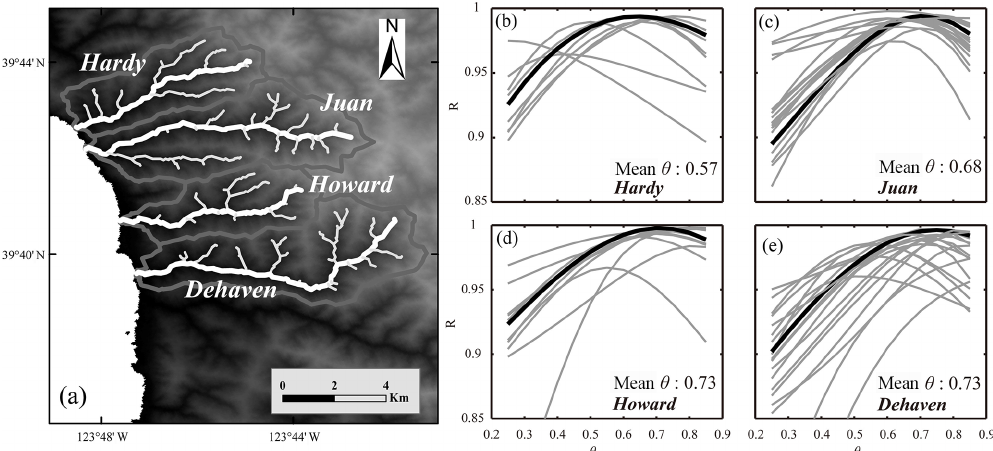
Figure 11. Correlation coefficients of χ − z plots as a function of θ . (a) Location of the streams. (b–e) Correlation coefficients of χ − z plots based on a range of θ values. Black thick lines indicate